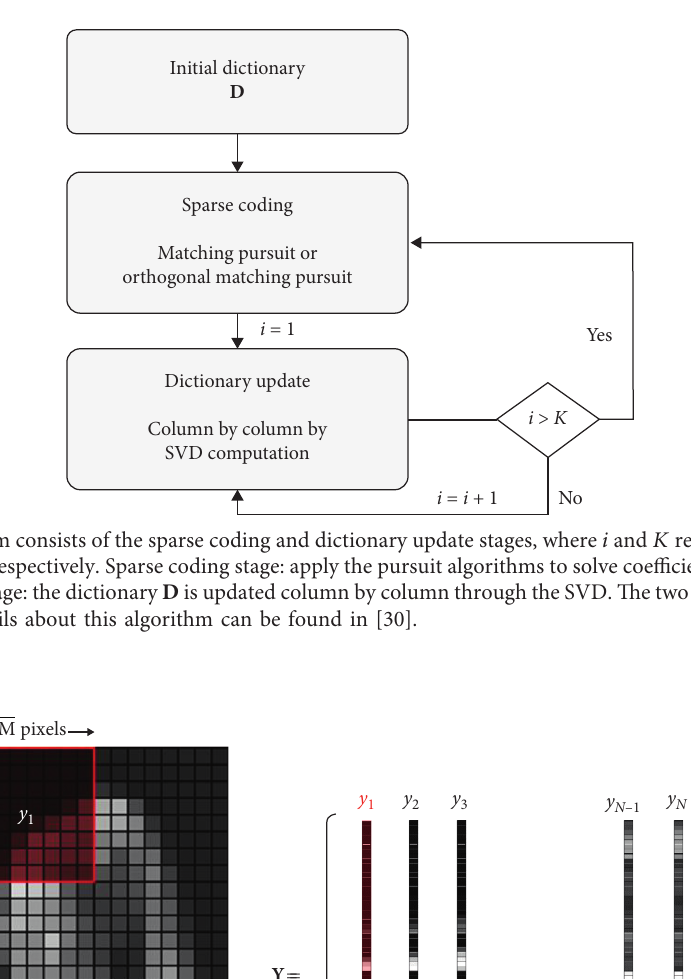
i in the given image. The extracted patches can